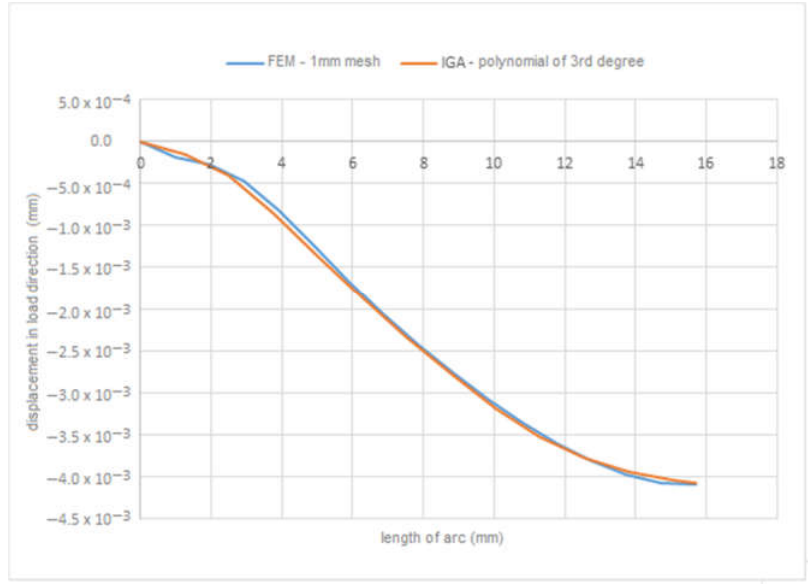
Figure 4. Comparison of displacements in load direction. Table 1. Computed displacements of the points for the different solution methods.